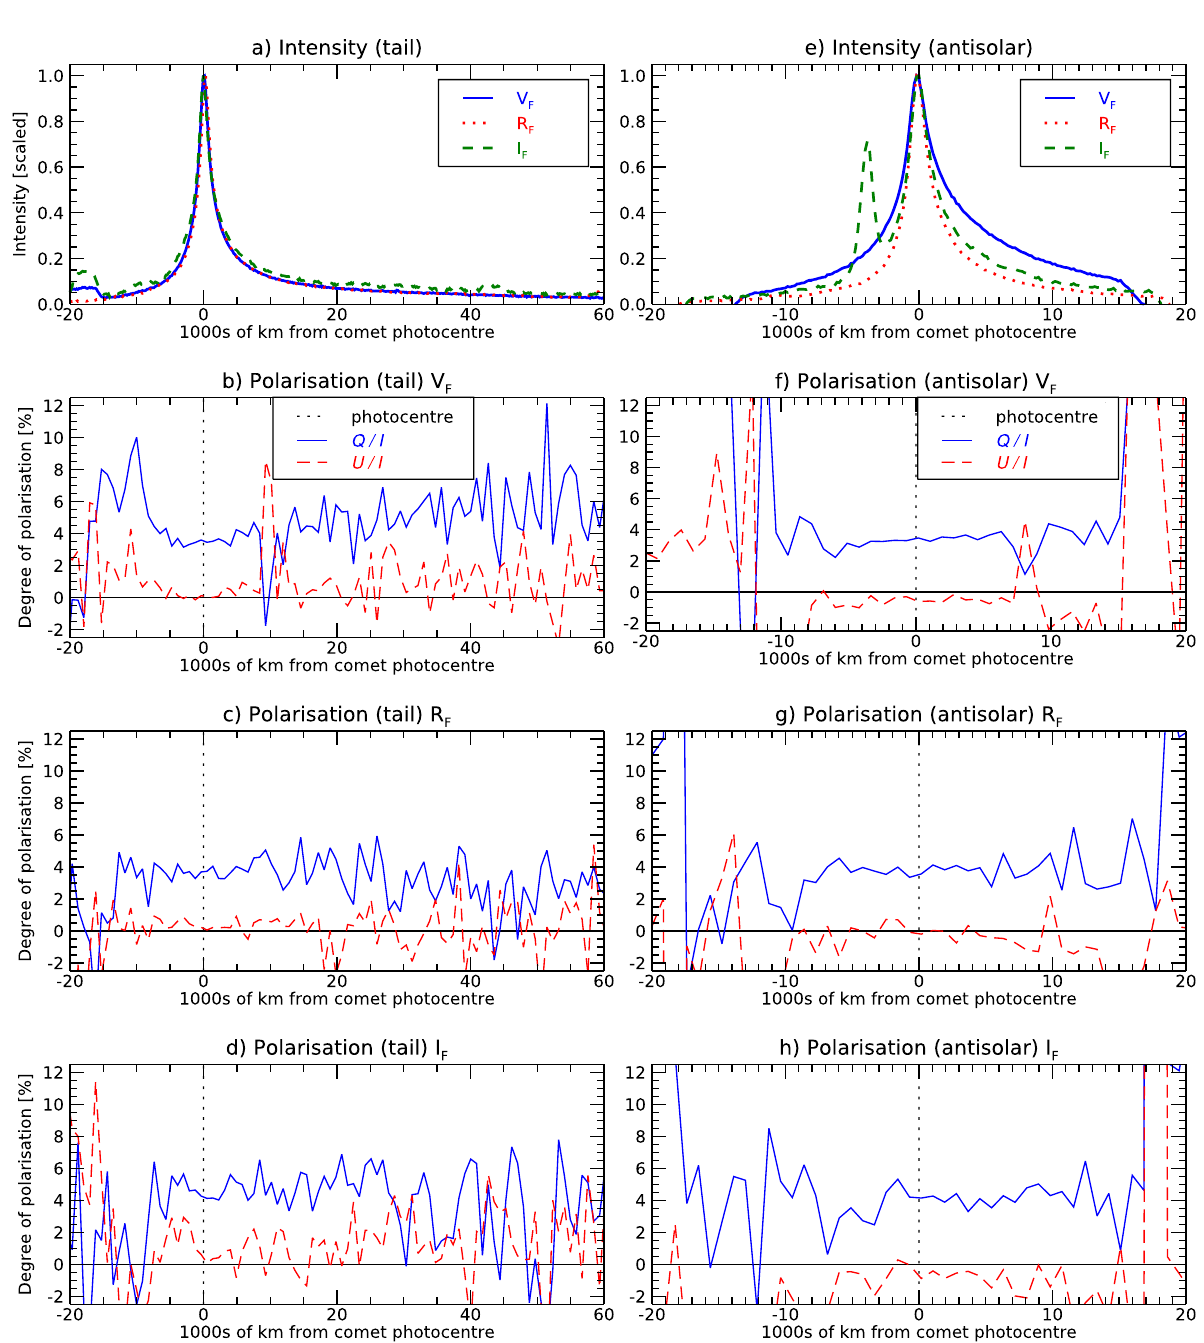
Fig. 4 Normalised intensity pro fi les and polarimetric pro fi les of 2I/Borisov. We have considered the observations in all fi lters V F , R F and I F along the dust tail in a direction of the extended dust tail, which is intermediate between the anti-sunward direction and the direction opposite to the heliocentric velocity (panels a – d ), and along the anti-sunward direction (panels e – h ). The photometric intensities are affected by occasional contamination from background stars. P r (represented with blue solid lines) is constant along both directions, while, as expected from symmetry, U / I (represented with red dashed lines) is close to zero throughout. The spatial dispersion is 177 km/pixel (1 pixel = 0.126 ″ ), but to increase the signal-noise ( S/N ), polarimetric data were rebinned to 5 pixels (880